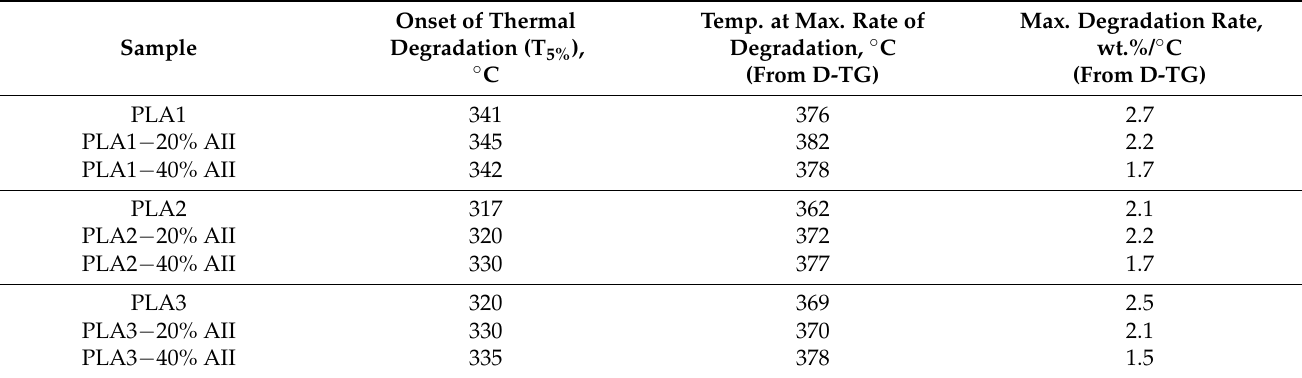
Table 2. Thermal parameters of PLAs and PLA-AII composites as determined by